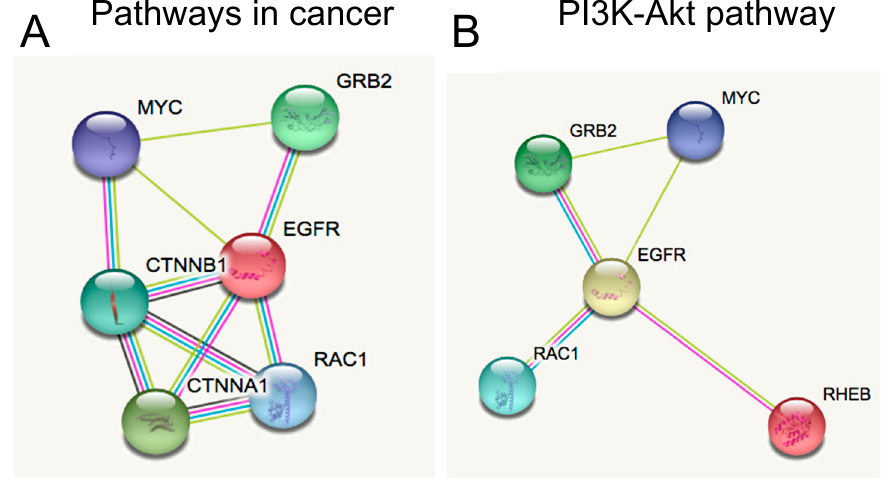
Figure 6. Putative targets of down-regulated miRNAs in SHH MB CSC enriched pathways, include ( A ) pathways in cancer and ( B ) PI3K-Akt pathway.